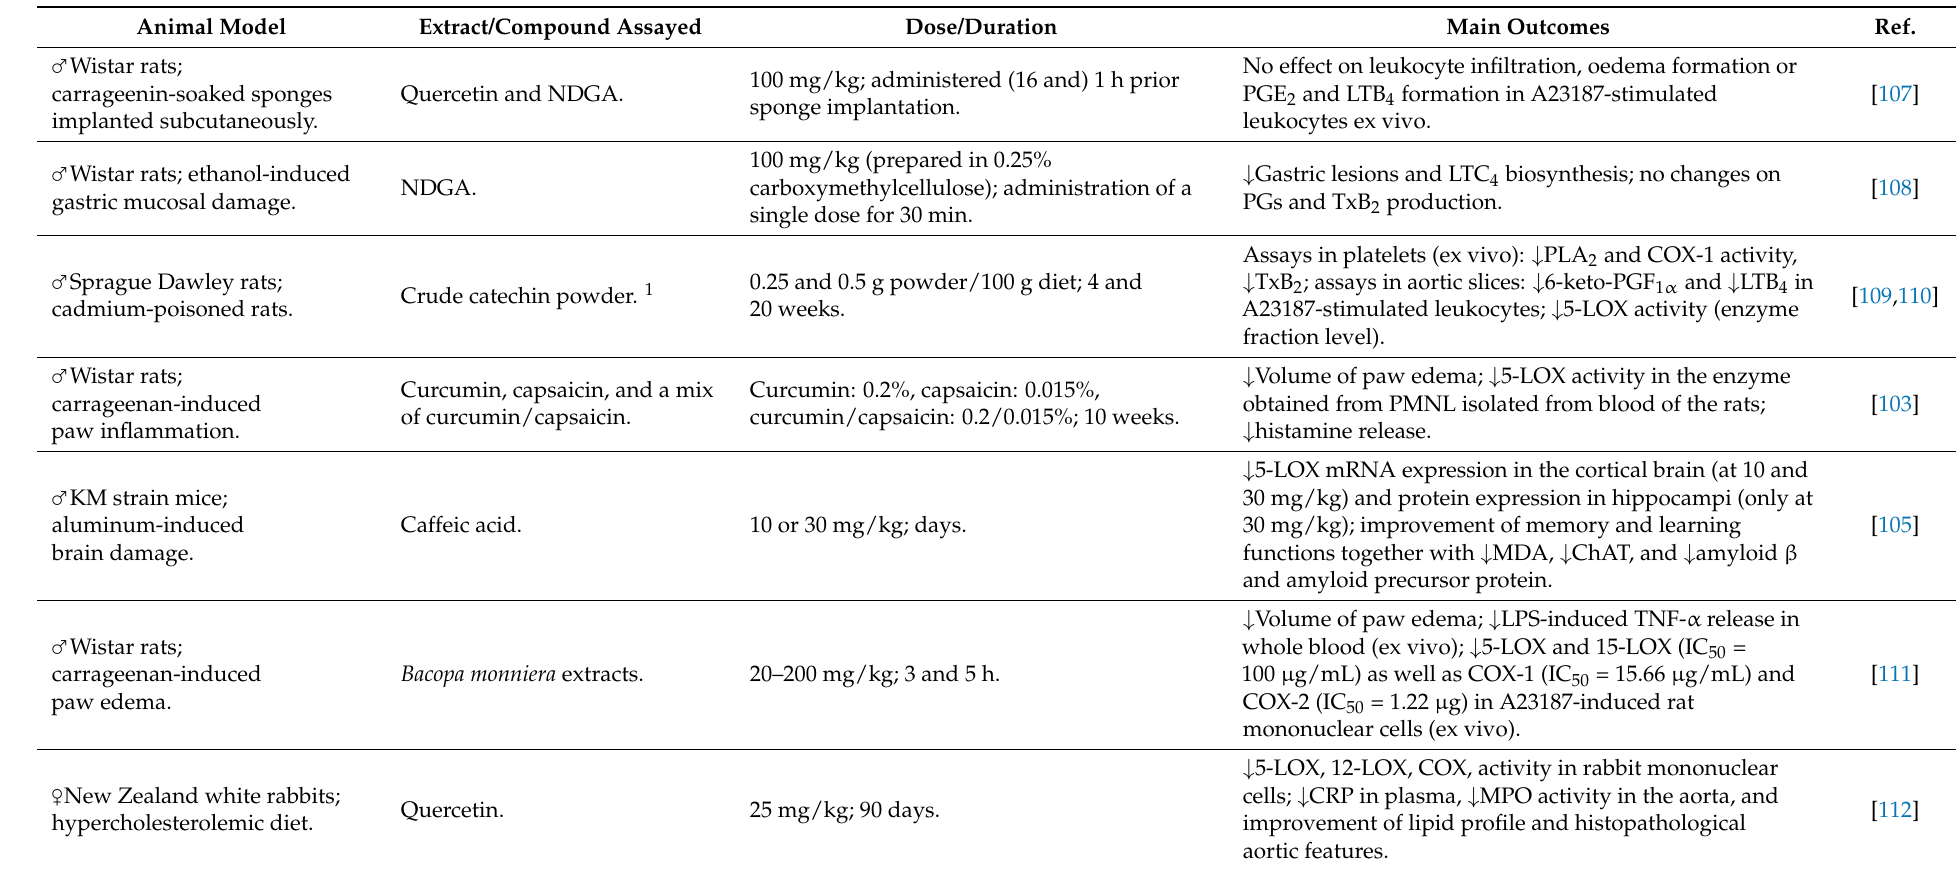
Table 2. In vivo studies carried out with (poly)phenols-rich extracts or individual compounds in relation to inflammation and 5-LOX